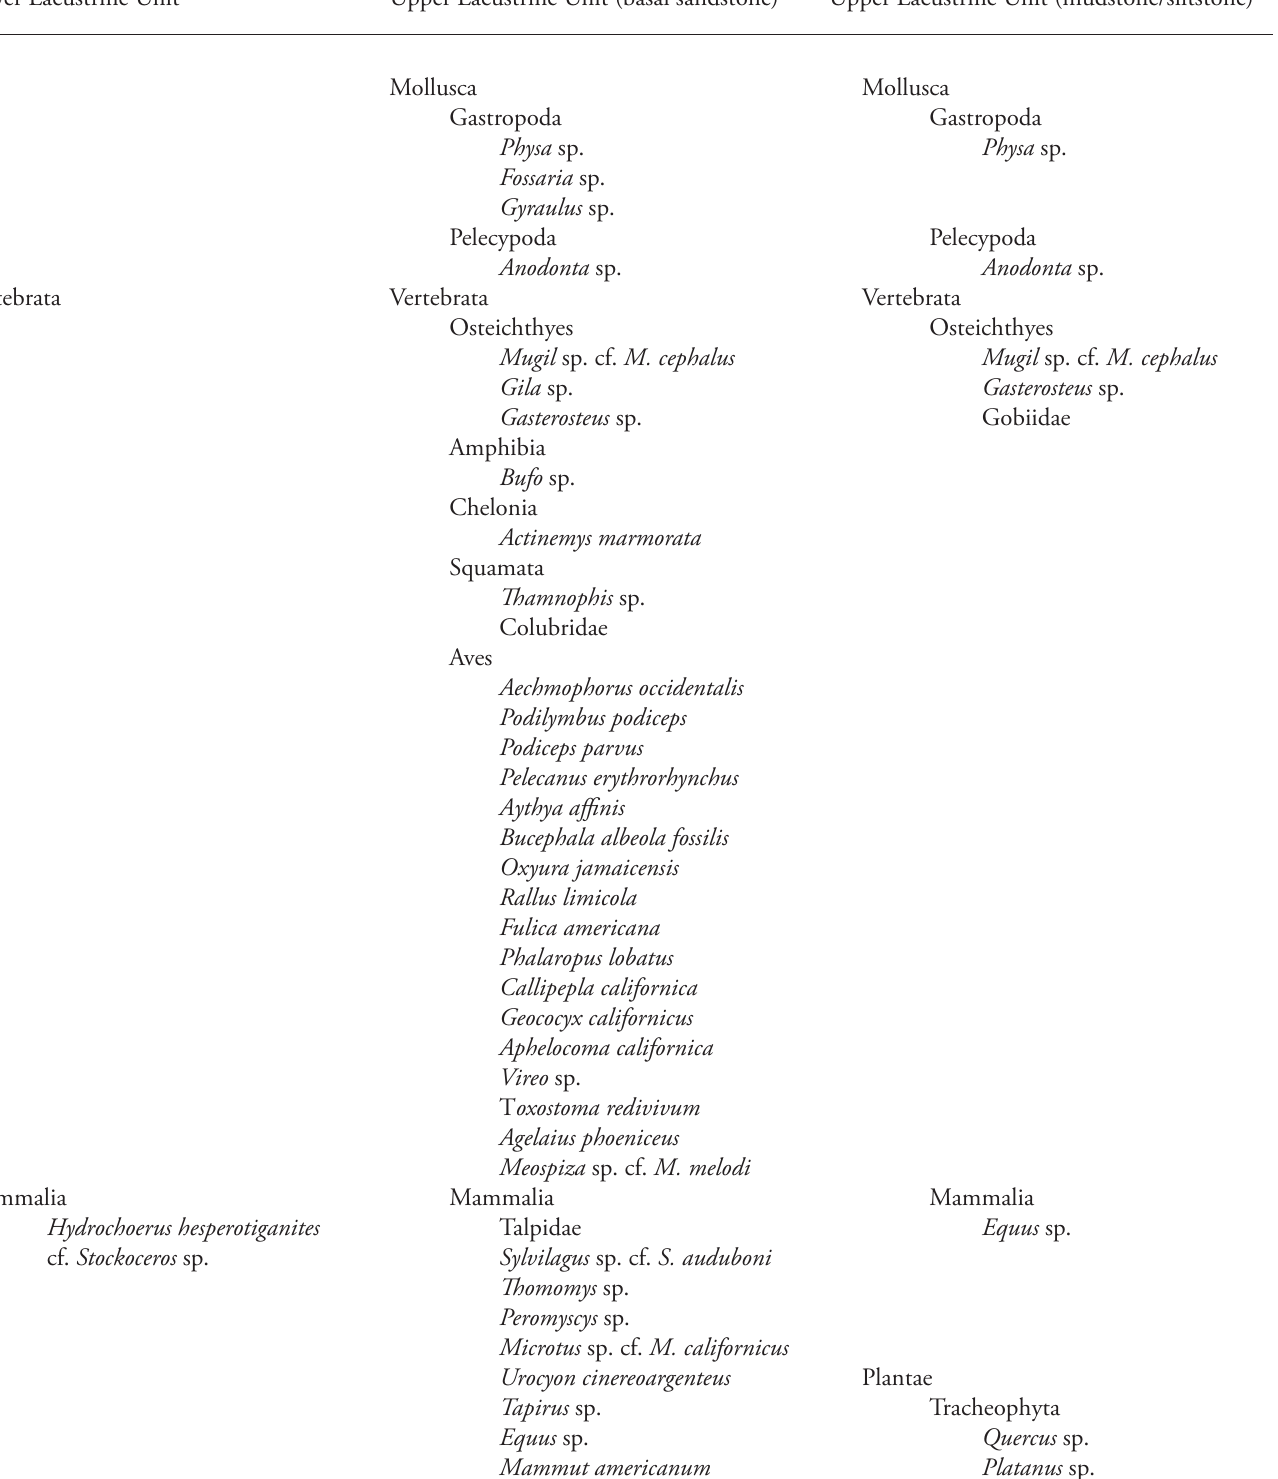
Table 1. Faunal lists for the three depositional units producing fossils Lower Lacustrine